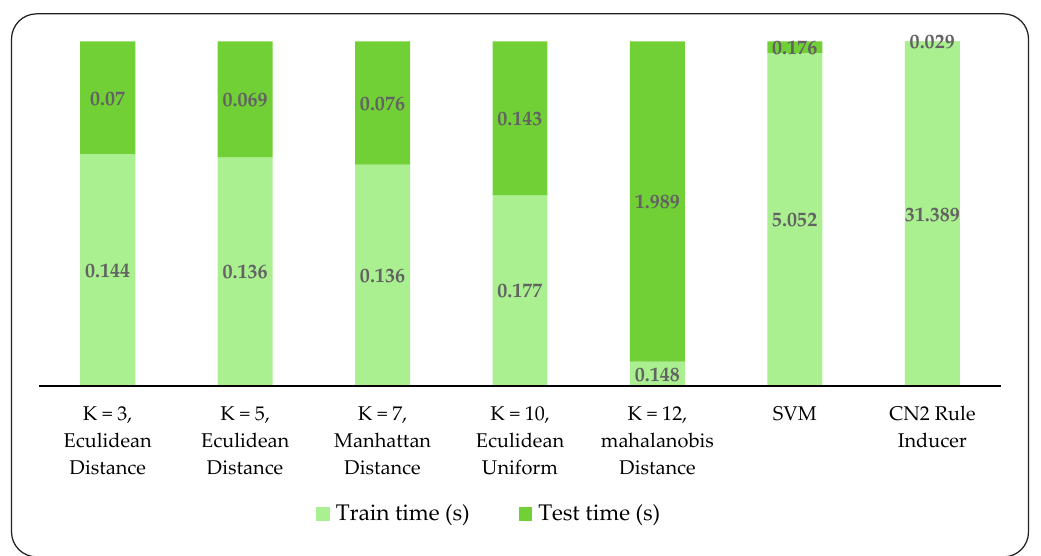
Figure 3. Performance comparison of different models.